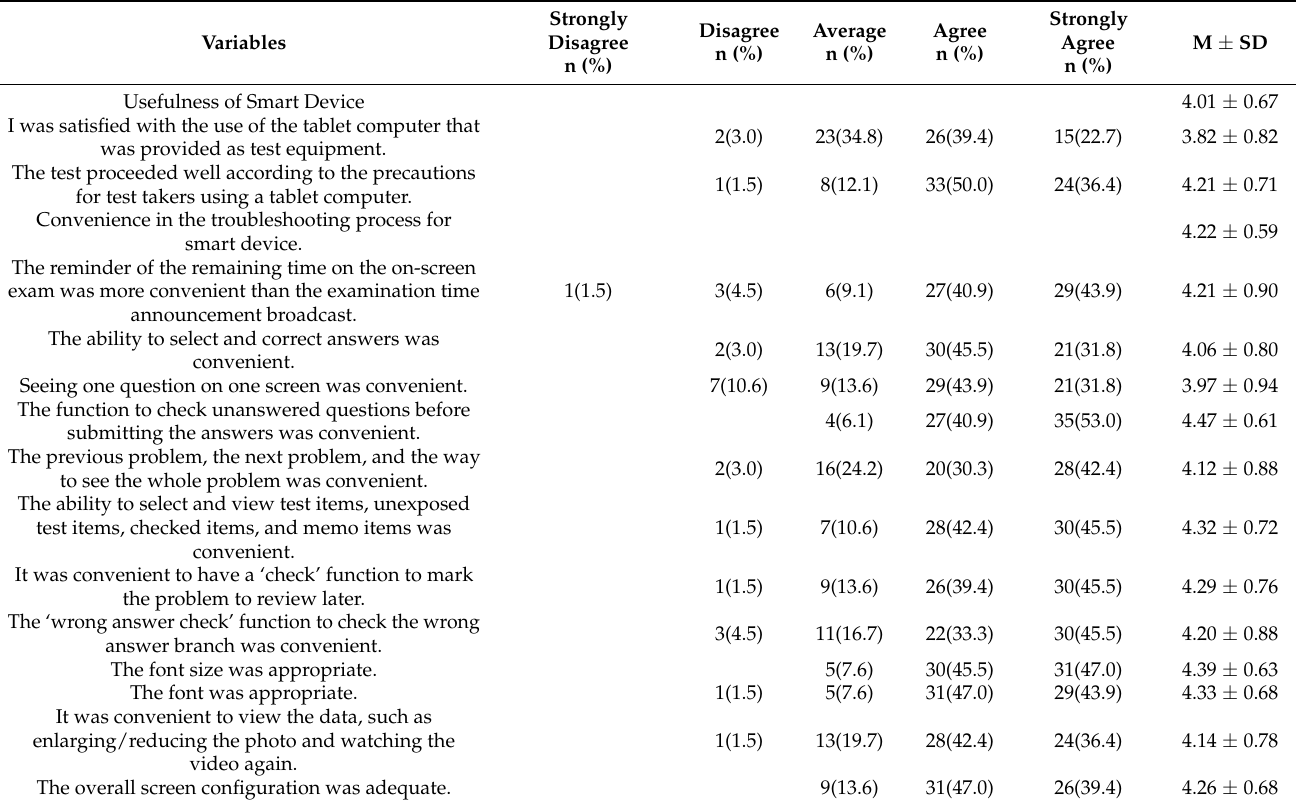
Table 2. Usefulness of UBT ( n = 66).